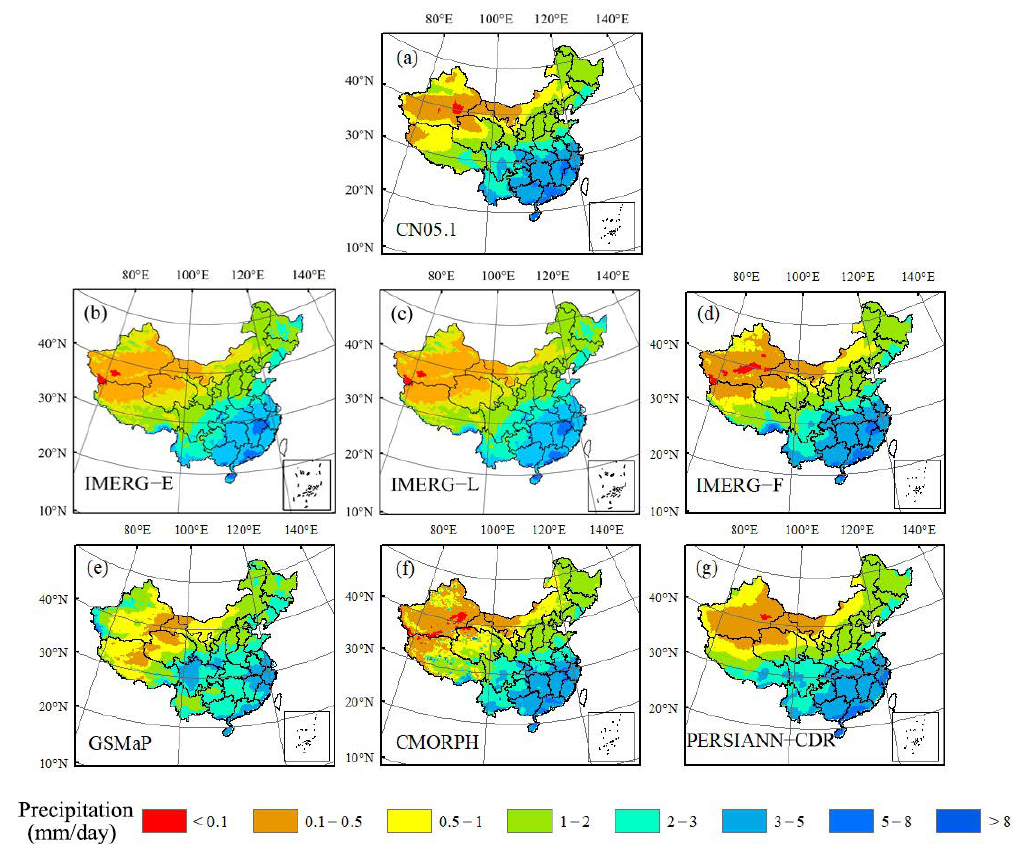
Figure 2. Distribution of daily mean precipitation over mainland China from 2001 to 2015.